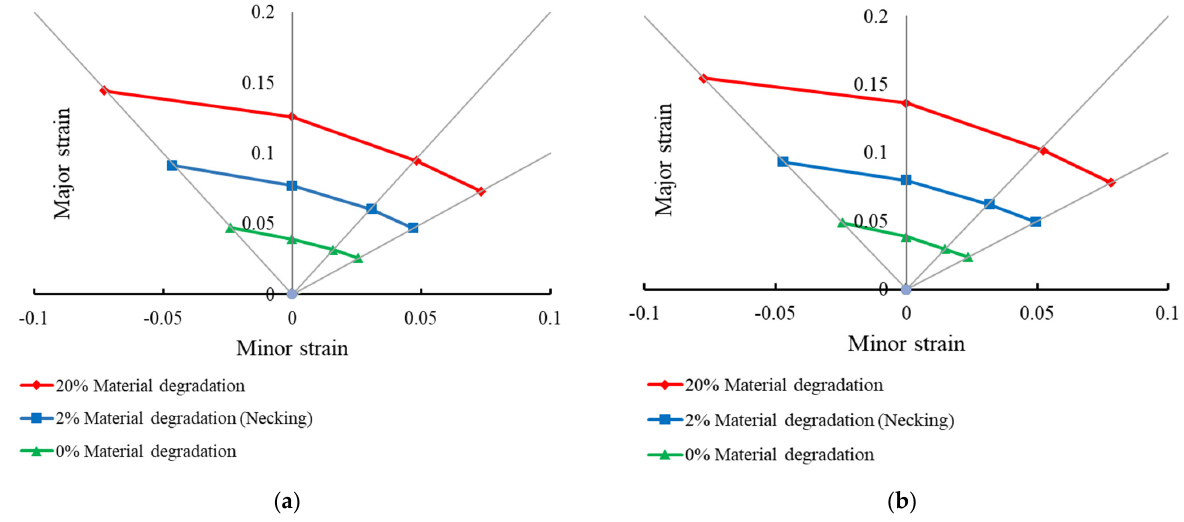
Figure 9. FLDs are showing marginal zones of ( a ) model A and ( b ) of model B. While in the case of K-B, by using models A and D, the values of major strains at the plane strain loadings were almost the same when the damage values were changed, while the values of the major and minor strains in other loading conditions changed. In addition, the marginal zone of the FLD was not observed for either model, as shown in Figure 10.